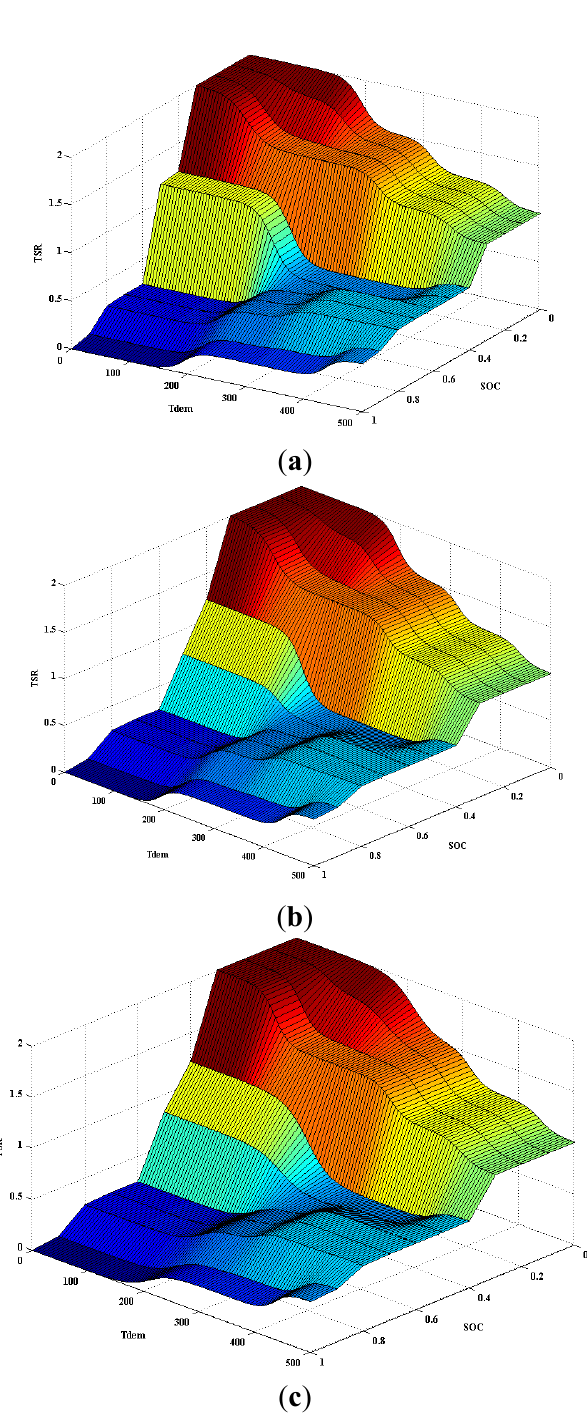
Figure 7. Changing trend of fuzzy controller TSR map under Urban Dynamometer Driving Schedule (UDDS): ( a ) TSR map for fuzzy controller in 500 s; ( b ) TSR map for fuzzy controller in 1000 s; and ( c ) TSR map for fuzzy controller in 1369